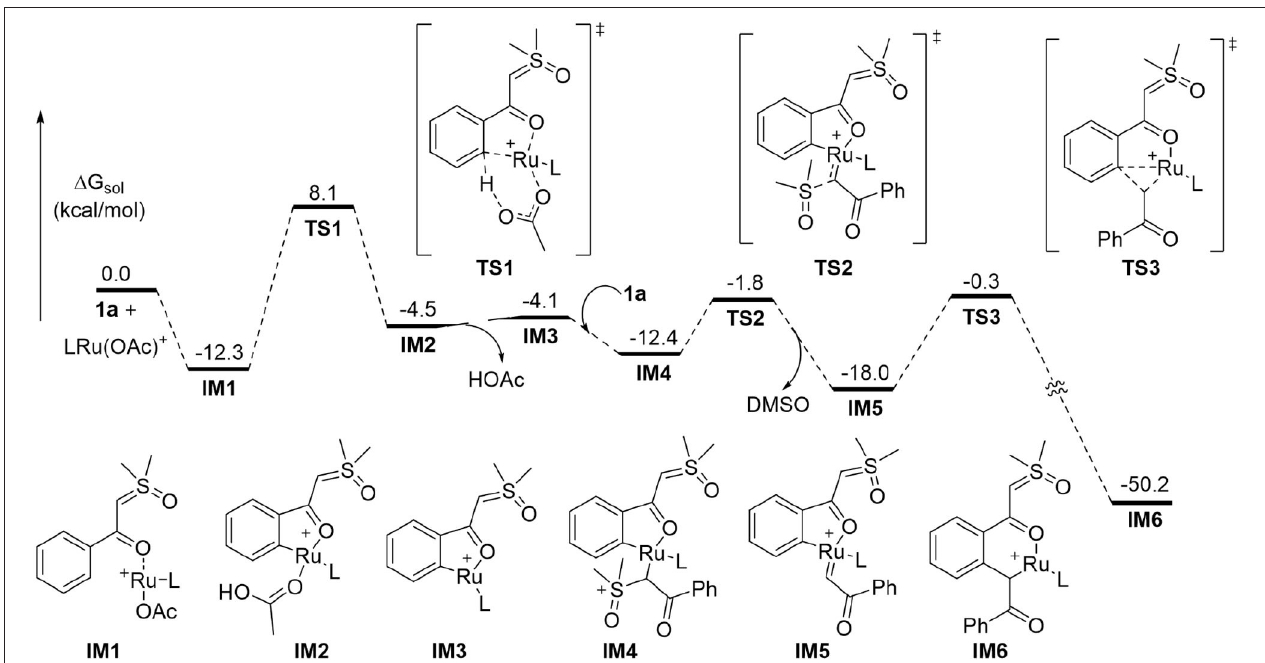
FIGURE 1 | DFT Results for the Formation of Six-membered Ruthenacycle (L = p -cymene).